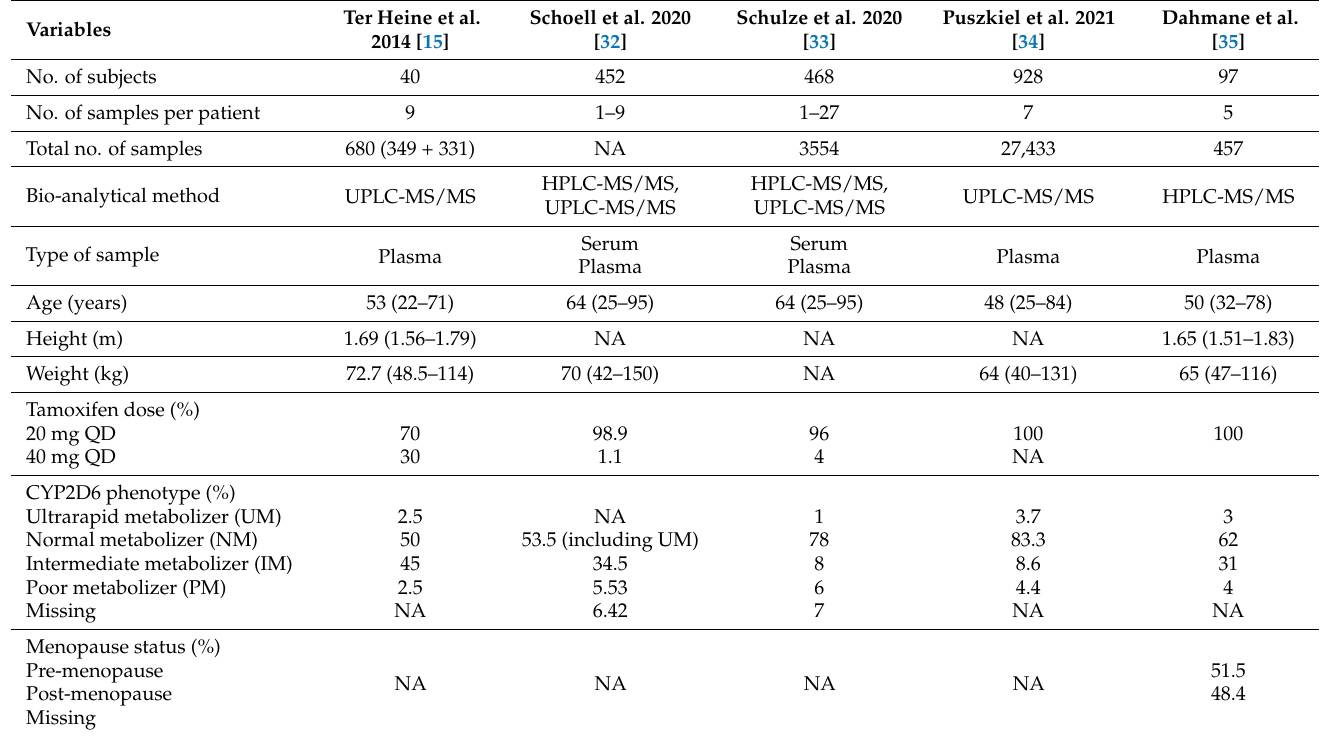
Table 2. Demographics of selected